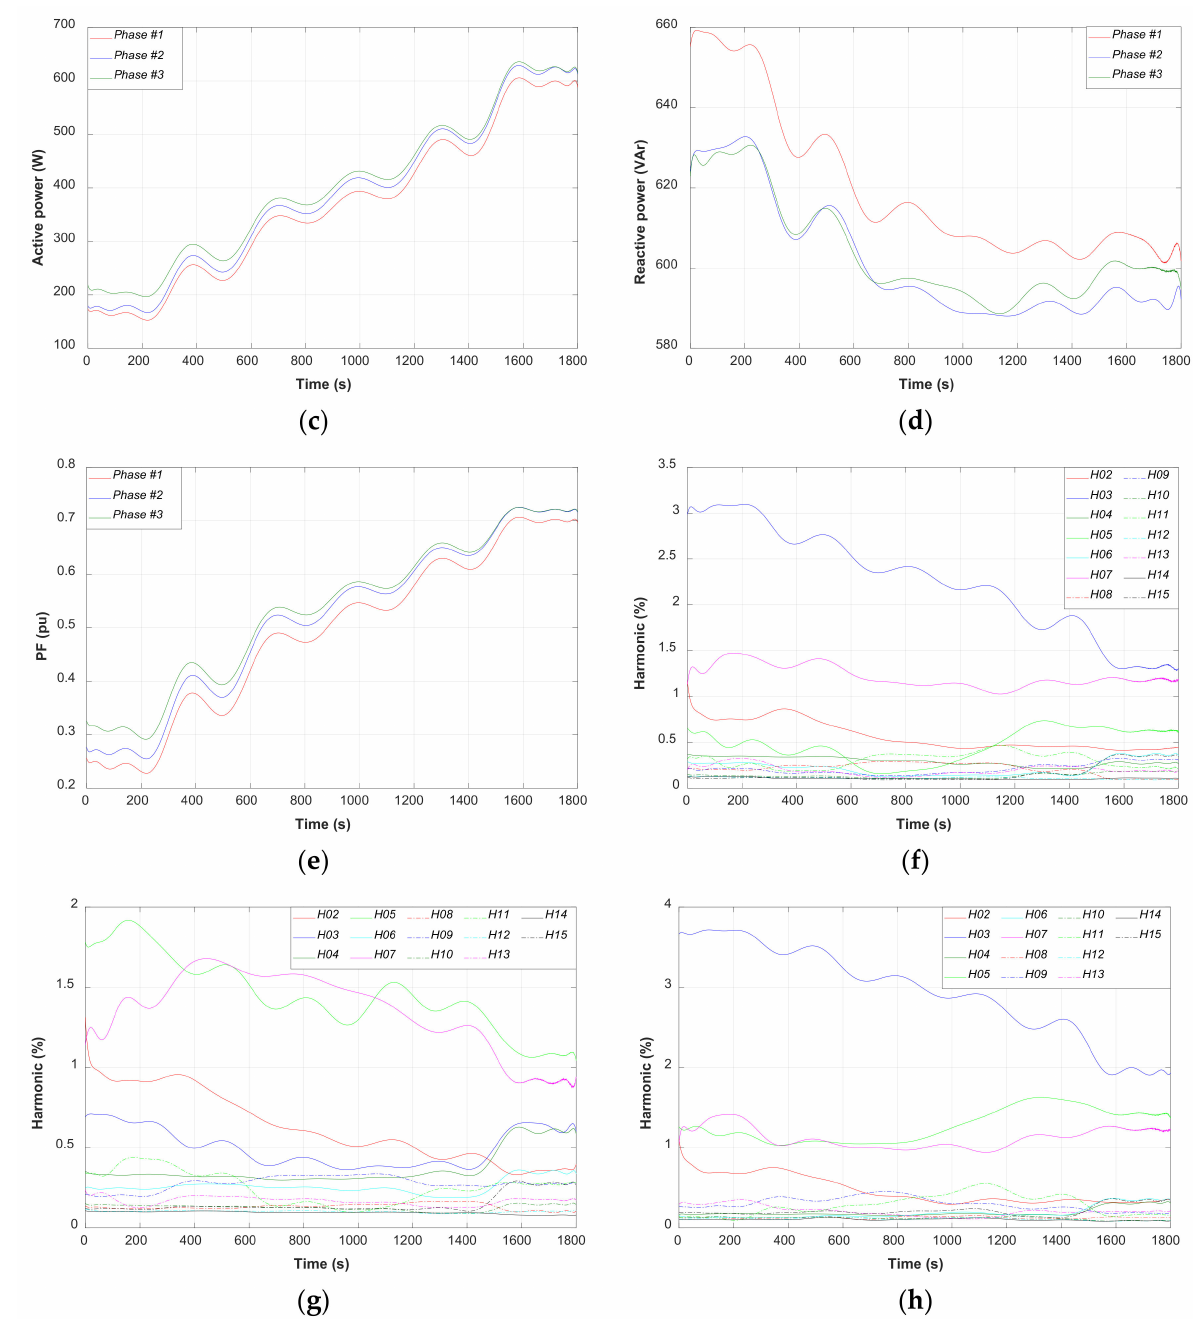
Figure 22. Measured data per phase for three-phase asynchronous with motor a wound rotor: ( a ) voltages; ( b ) currents; ( c ) active powers; ( d ) reactive powers; ( e ) power factor; ( f ) Phase #1 current harmonics; ( g ) Phase #2 current harmonics; and ( h ) Phase #3 current